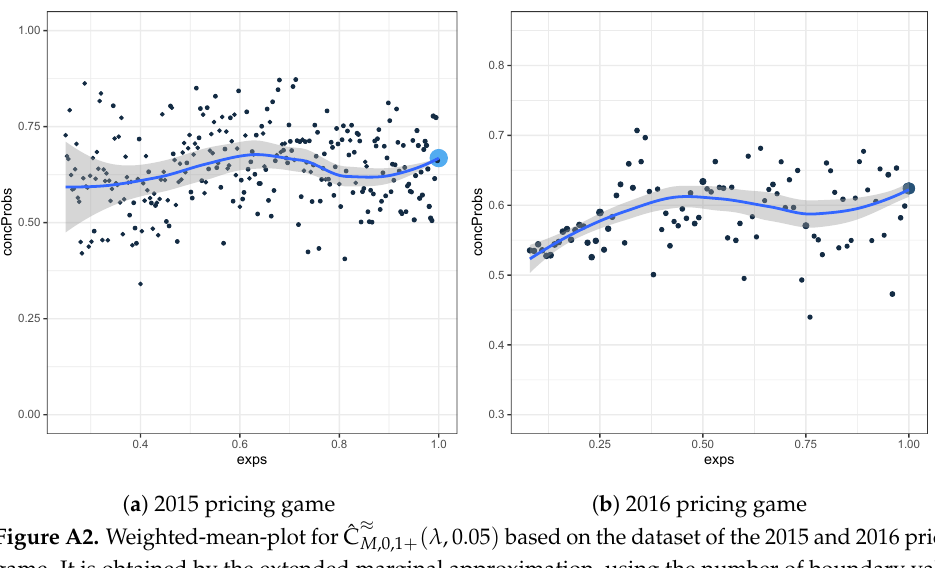
≈ ( λ ,0.05 ) based on the dataset of the 2015 and 2016 pricing Figure A2. Weighted-mean-plot for ˆC M ,0,1 + game. It is obtained by the extended marginal approximation, using the number of boundary values that resulted in the lowest bias.